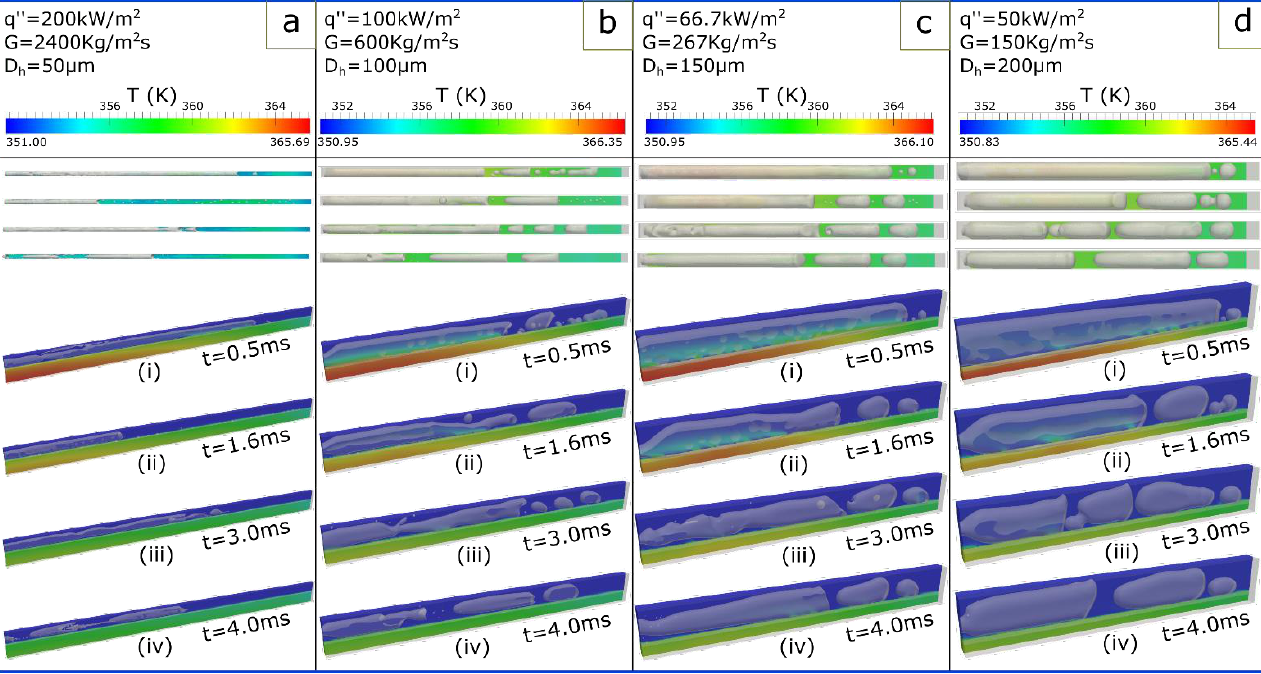
Figure 3. Numerical flow visualisation results of hydrophilic cases for constant 𝑞 = 1.80 × 10 −2 W and 𝑉̇ = 9.1611 × 10 −9 m 3 /s . Four common time instants are shown for all cases, whereas at the top of each column, the heat flux, mass flux, and hydraulic diameter, for each examined case ( a – d ) is shown.